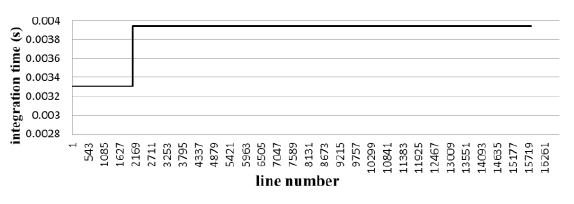
Figure 7. Integration time of h4235_0001_s22